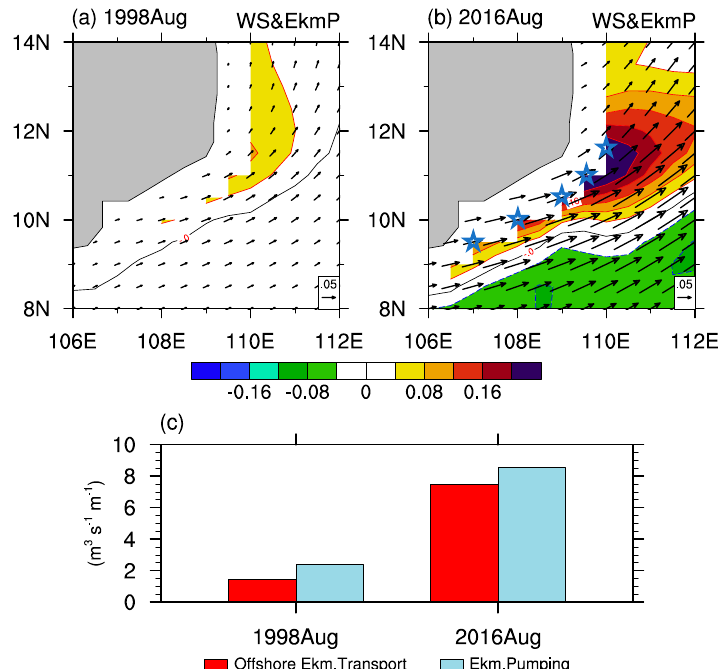
Figure 6. Spatial distribution of wind stress (vector, units: N / m 2 ) and wind-driven Ekman pumping velocity (shading, units: 10 − 4 m / s) during August in 1998. ( b ) Same as in ( a ) but for the results in 2016. Blue stars indicate the coastal points at which we calculate the Ekman transport and Ekman pumping. ( c ) Comparison of the August offshore Ekman transport and Ekman pumping integrated along the coastal grid in 1998 and 2016.